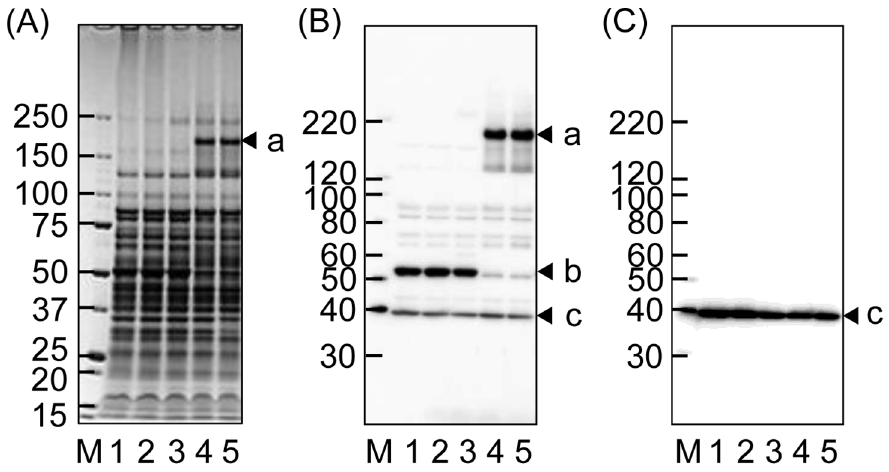
Figure 4. Effect of temperatures on mobility of TmpC and Msp in SDS-PAGE. The whole-cell lysate of the wild type of T . denticola was mixed with a loading buffer for SDS-PAGE, and heated at 100 u C (lane 1), 80 u C (lane 2), 60 u C (lane 3), or 37 u C (lane 4) for 10 min. Samples in lane 5 were not heated (maintained at room temperature). The SDS-PAGE gels (5–20% gradient) were subjected to CBB-staining (A), and western blotting using anti- T . denticola antiserum (B) and anti-TmpC antiserum (C). Arrowheads indicate conformational Msp (a), monomeric Msp (b), and monomeric TmpC (c). Msp, but not TmpC, appears to form a complex. A molecular-weight standard (lane M, kDa) is shown at the left of each panel.